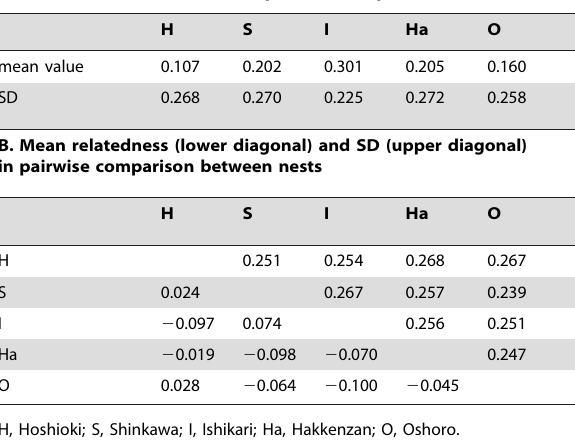
Table 3. Mean value and standard deviation of genetic relatedness within and between